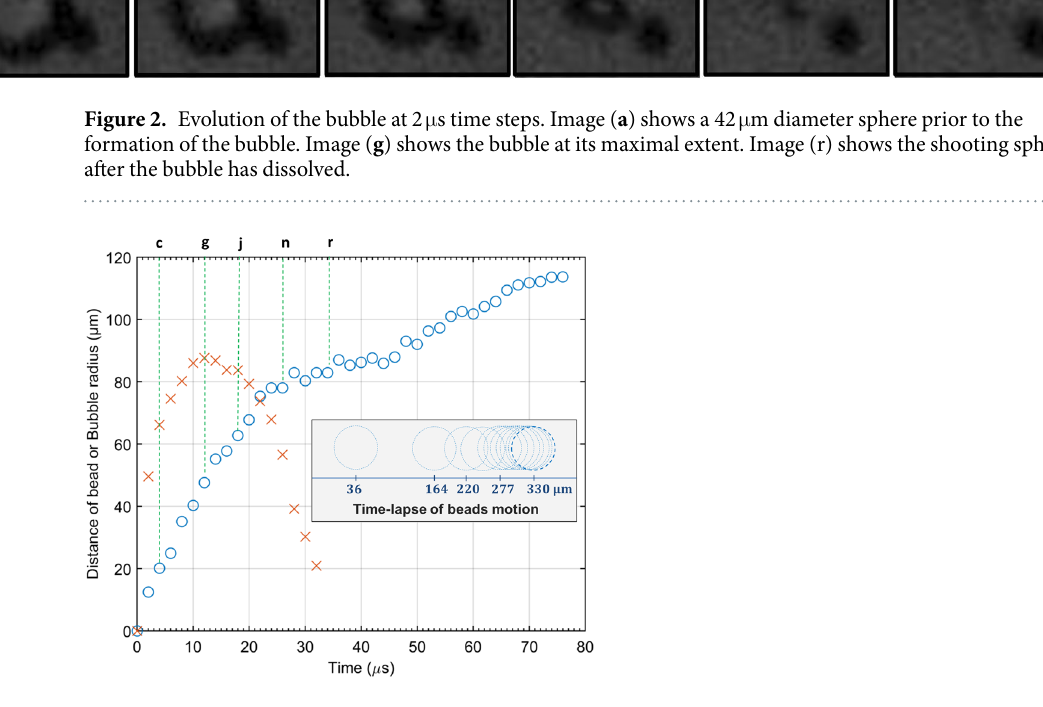
Figure 3. Typical micro-sphere motion and the corresponding bubble radius. Micro-sphere location is shown with blue ‘o’ marks while the radius of the bubble with orange ‘x’ marks. Letters corresponds to a respective frame in Fig. 2. Inset depicts the motion of a typical micro-sphere after the bubble has vanished with 200 μ s between consecutive